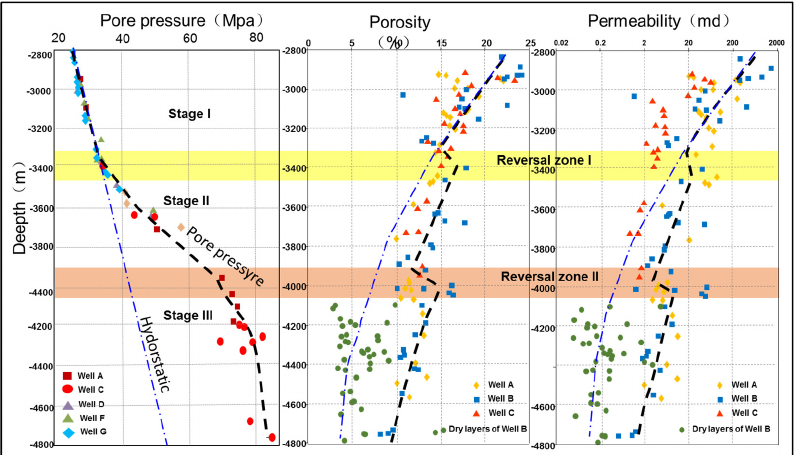
Figure 16. The measured pressure and porosity and permeability vs. depth in the Pinghu area. The first porosity and permeability inversion zones (yellow band) occur between 3350 m and 3450 m. The second porosity and permeability inversion zones (red bar) occur between 4300 m and 4450